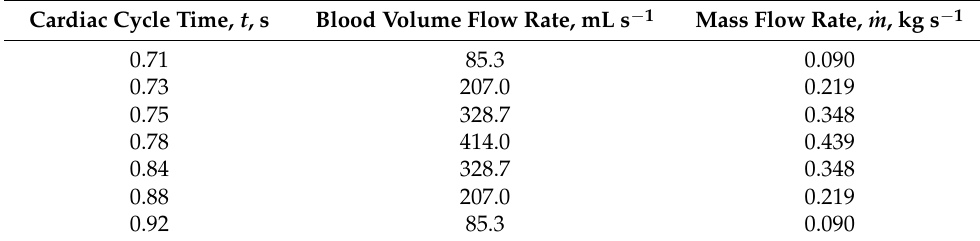
Table 1. Analyzed blood volume and mass flow rates.